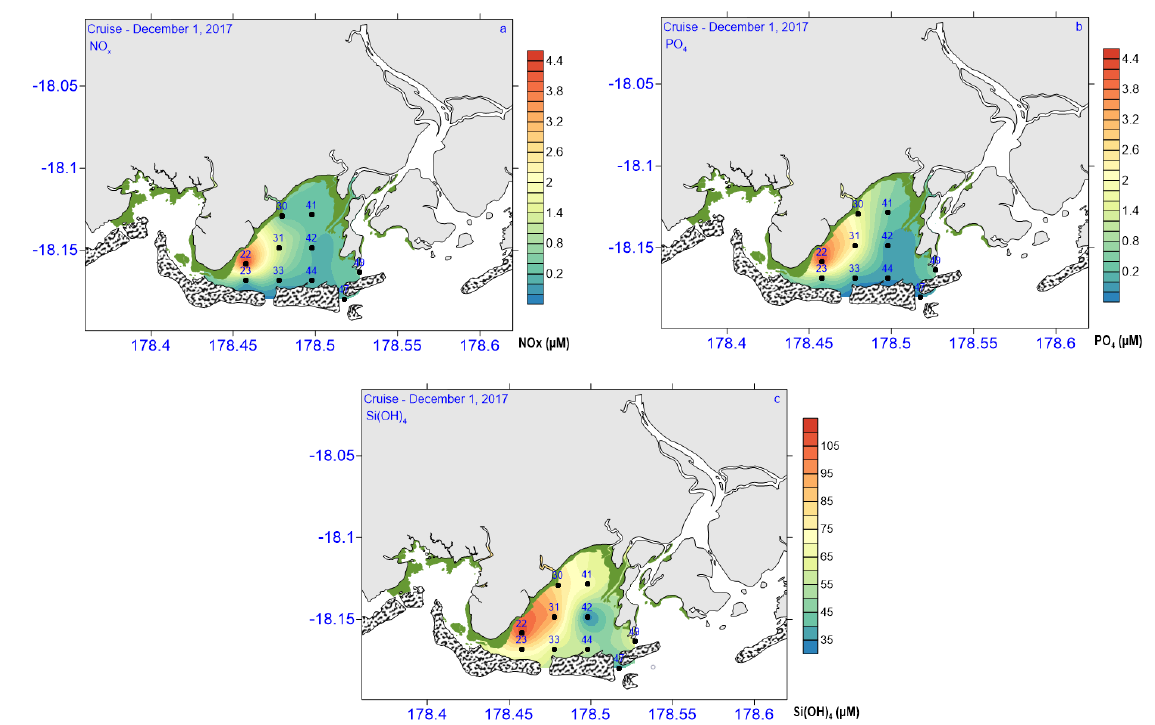
Figure 4. Color maps for biogeochemical variables ( a ) dissolved organic nitrogen (DON); ( b ) dissolved organic carbon (DOC); ( c ) Chla and ( d ) suspended particulate matter (SPM).